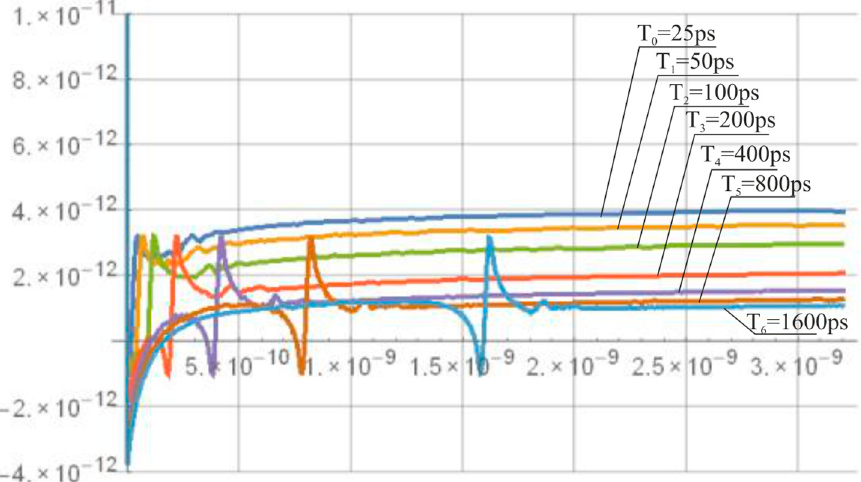
Figure 36. Differences of propagation delays of symmetrized multiplexers S Si and S Ri vs. input time interval T In with T m = 250 ps.